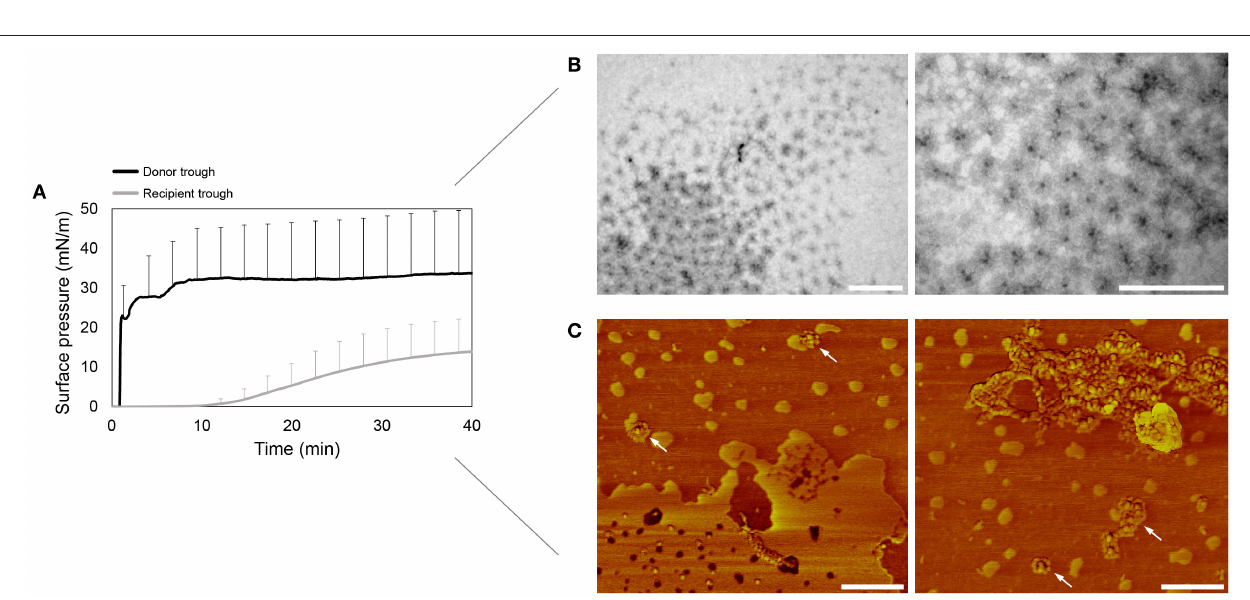
FIGURE 1 | Interfacial activity of rhSP-D. (A) Recording of surface pressure as a function of time for the adsorption of an aliquot of 10 µ L at 0.34 mg/mL (3.4 µ g) of rhSP-D injected into the subphase of a Wilhelmy balance. (B) Adsorption and spreading isotherms of rhSP-D upon injection of an aliquot of 20 µ L at 0.6 mg/mL (12 µ g) of the protein at the air-liquid interface in a double-Wilhelmy balance. Surface pressure measured in the donor (black line) and recipient troughs (gray line). (C) Fluorescence emission spectra of the F-rhSP-D detected in the whole volume taken from the recipient trough at the end of the experiments. Data represented by the mean and standard deviations of three different replicates.